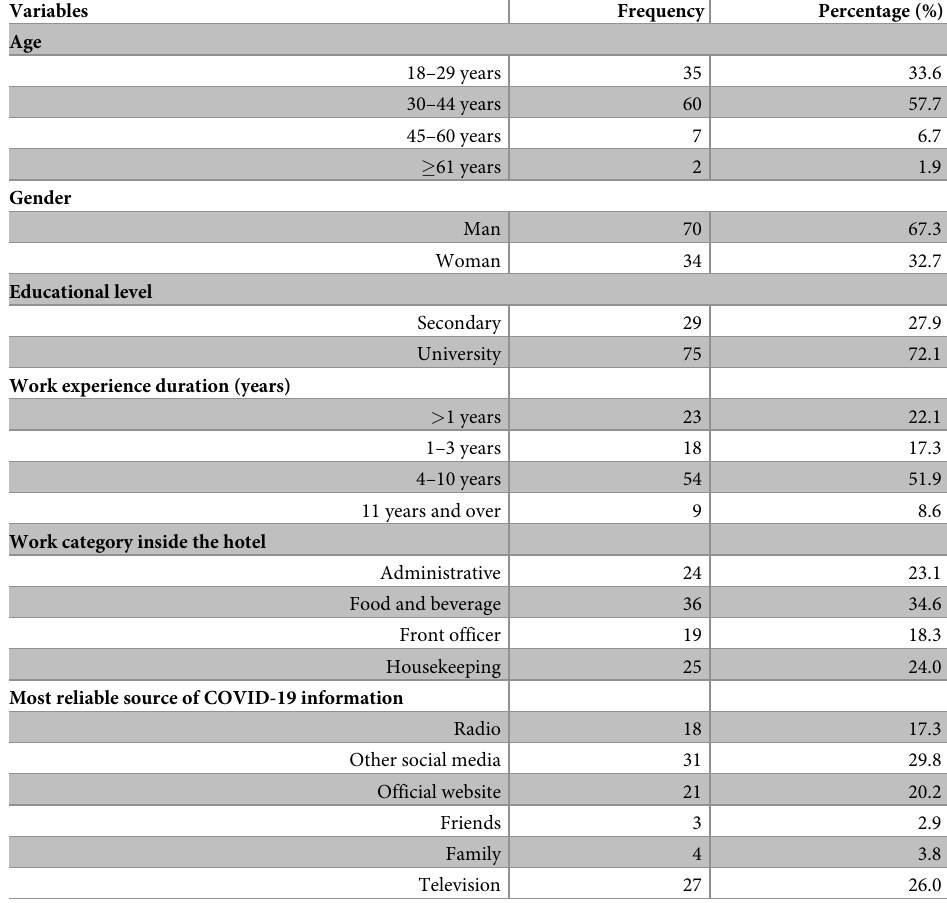
Table 1. Sociodemographic characteristics of hotels’ staff in Kigali (N =